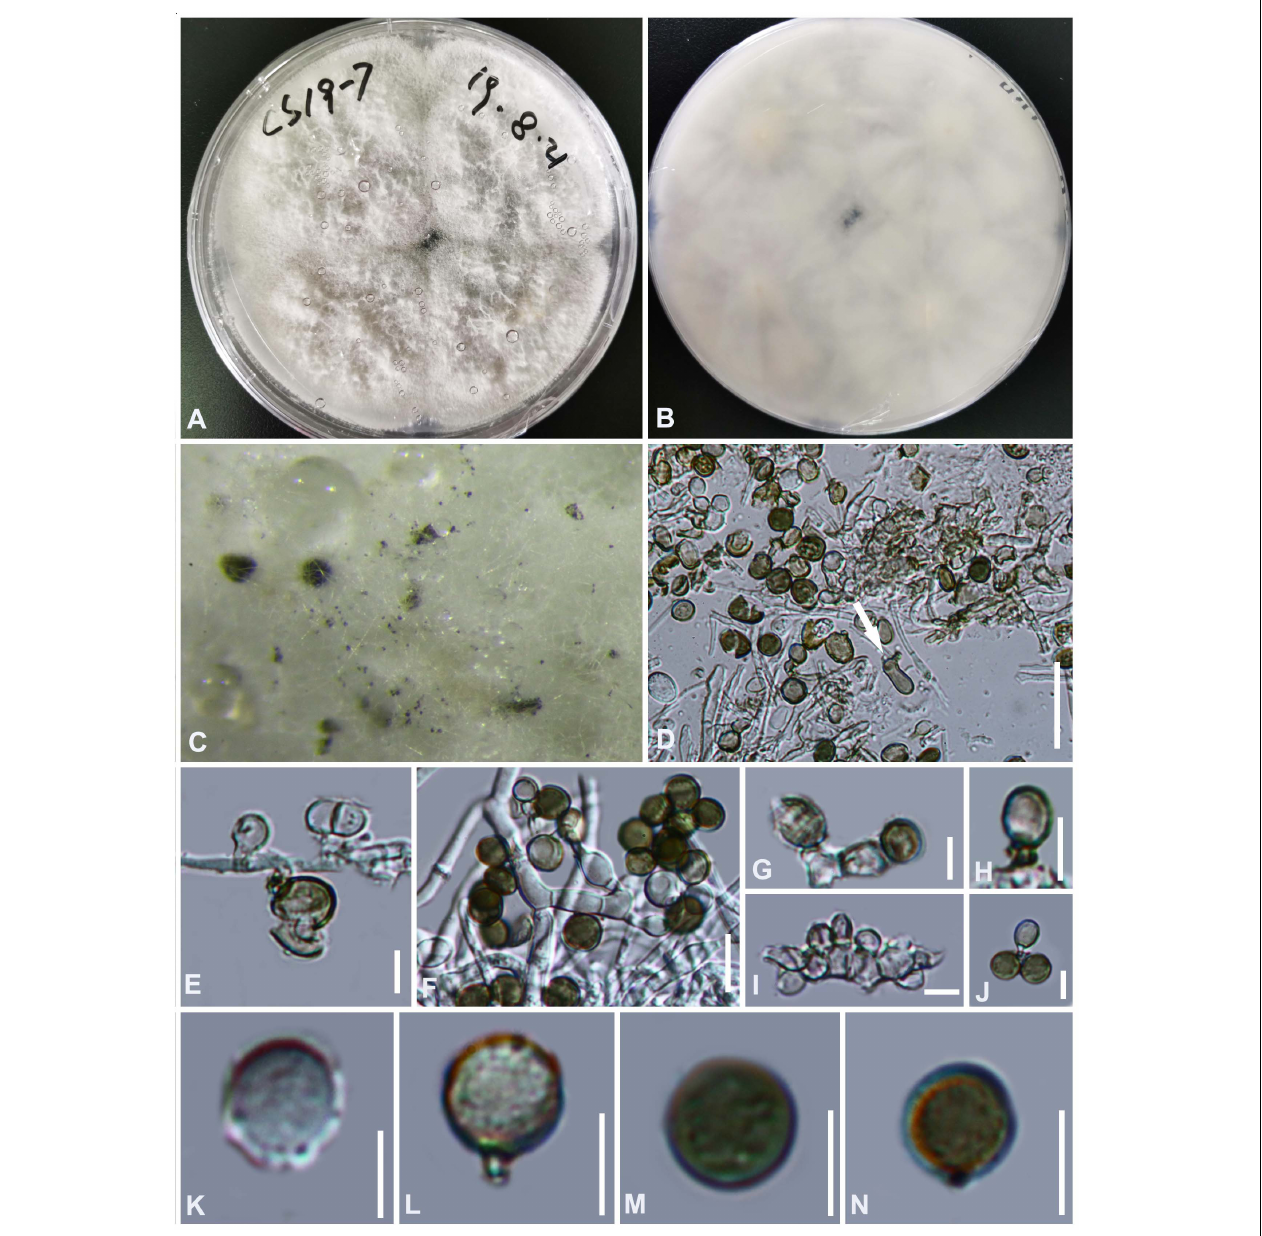
FIGURE 10 | Arthrinium arundinis (GZAAS 20–0116) (A,B) culture. (C) Colonies on culture. (D) Sterile cell mixed among conidia. (E–J) Conidiogenous cells and conidia. (K–N) Conidia. Scale bars: (D) = 50 µ m. (E) = 5 µ m. (F) = 10 µ m. (G–N) = 5 µ m.